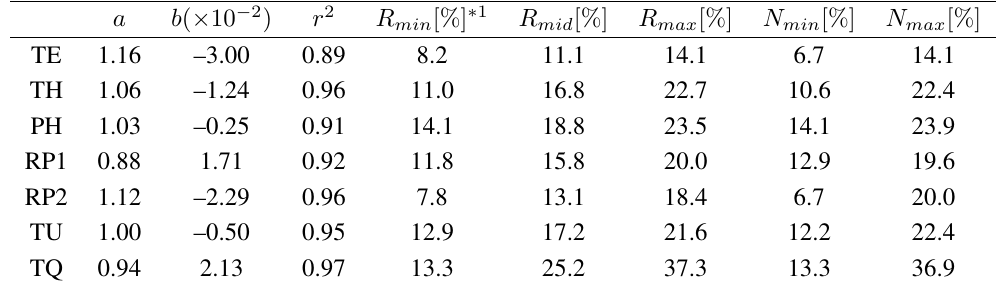
Table 2. Soil line parameters (slope a , NIR-intercept b ) and coefficient of determination ( r 2 ).